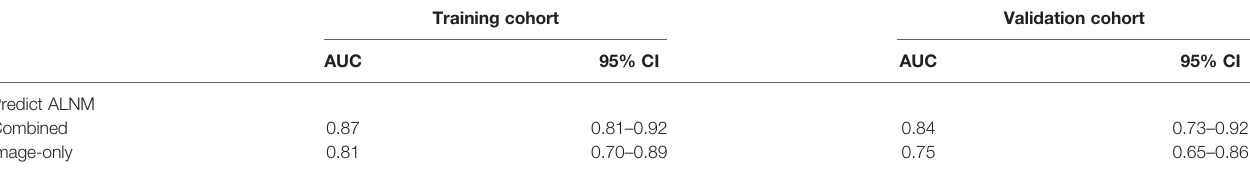
ALNM, axillary lymph node metastasis; AUC, area under the curve; CI, con fi dence interval. Combined model (image-only model+ lymphovascular invasion). Image-only model (ALN cortex thickness and obliterated ALN fatty